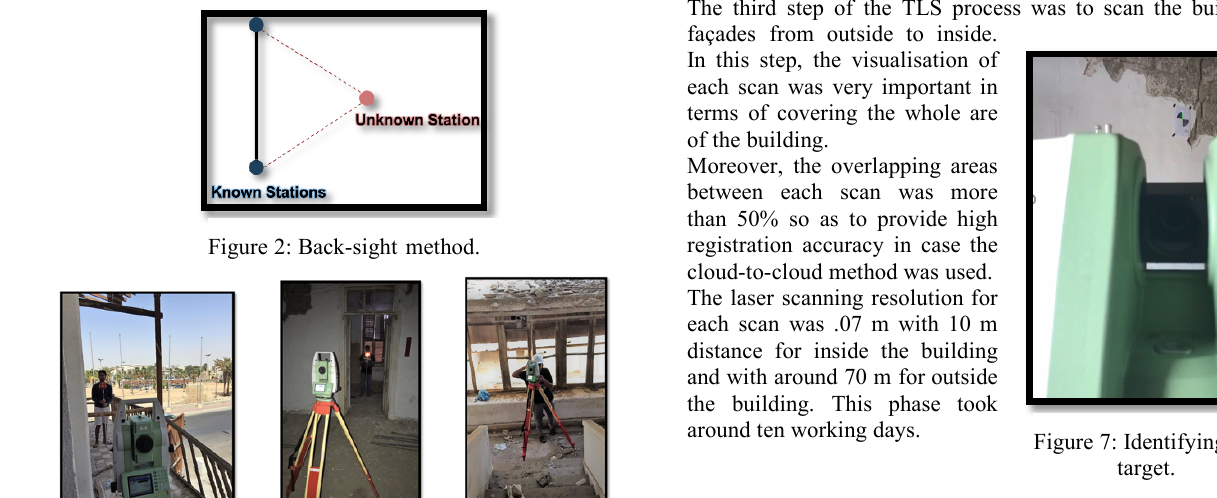
Figure 6: Utilising the (B/W) targets on the façades.